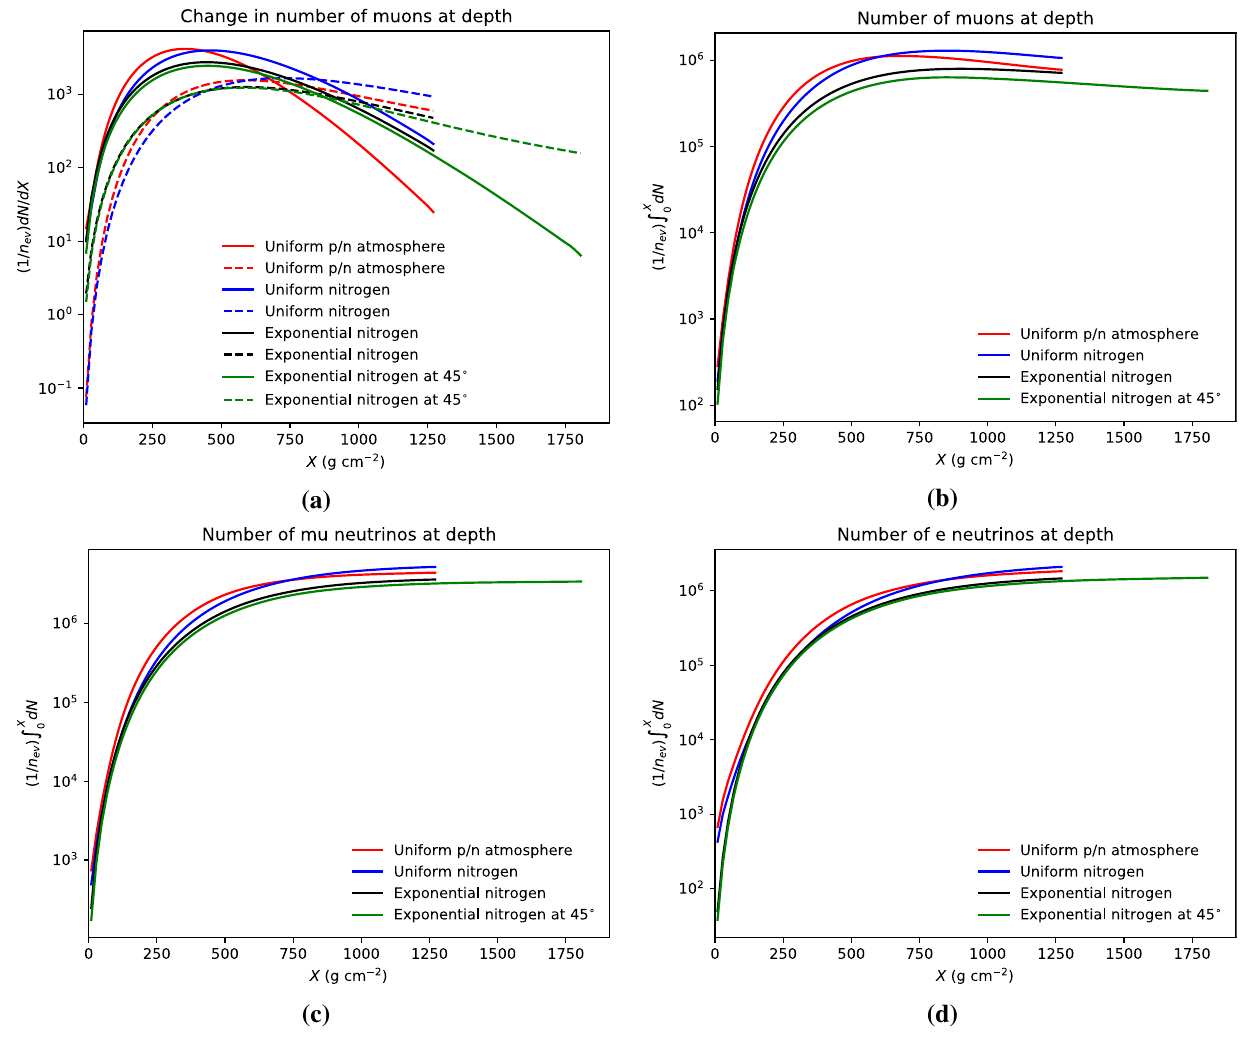
Fig. 13 Evolution of muons and neutrinos for the same cascades as in Fig. 12. Shown is the number of a muons produced (full) and decayed (dashed), b muons remaining, c muon neutrinos remaining and d electron neutrinos